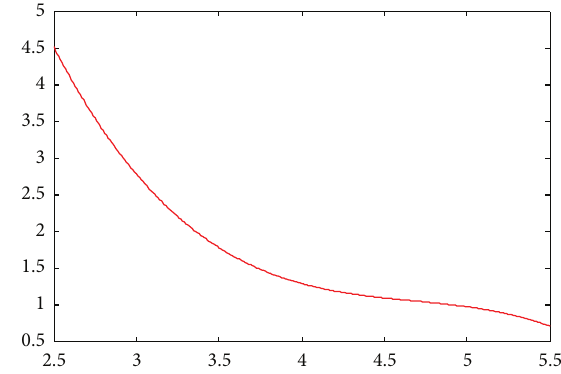
Figure 5: The diagram of Malmquist product index DMU 5 .